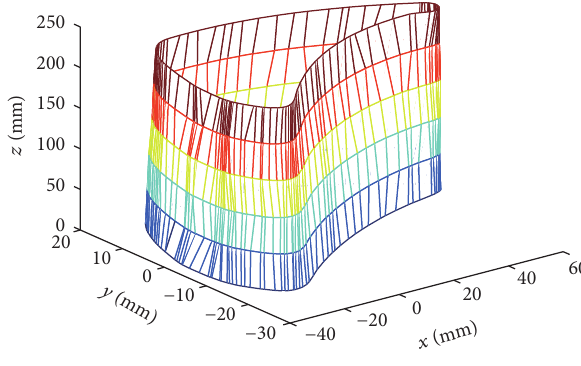
Figure 9: Rectangular grids.